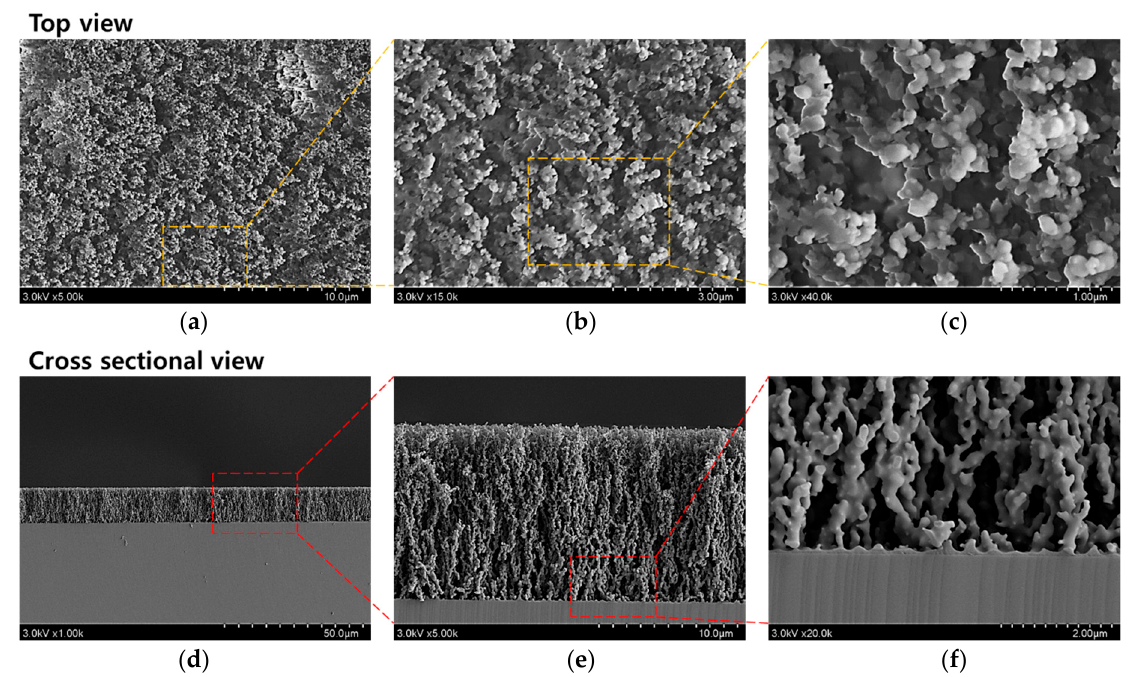
Figure 4. Field-emission scanning electron microscopy (FE-SEM) characterization of the polyaniline (PANI) films deposited on silicon (Si) substrates via the newly designed AP plasma polymerization process: ( a – c ) surface views, and ( d – f ) cross-sectional views.